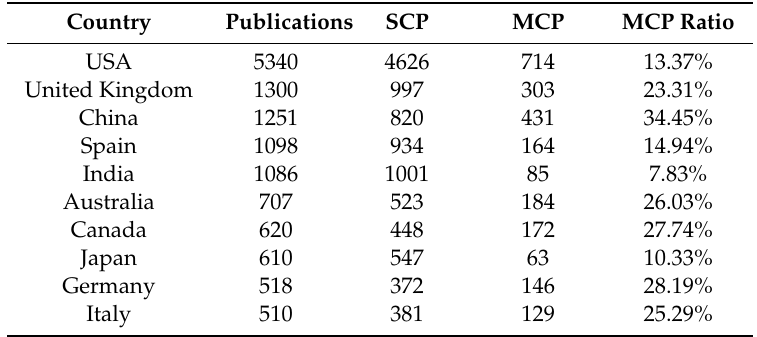
Table 5. Top 10 most productive countries.